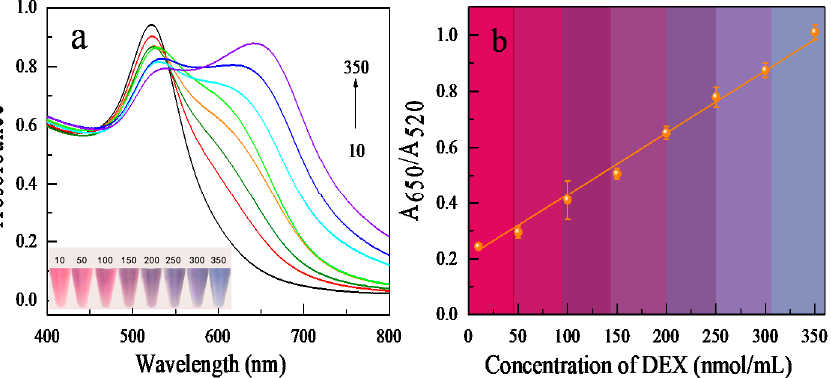
Figure 4. The aptamer-based DEX detection assay’s sensitivity. ( a ) Color and UV absorption spectra of sensing systems treated with 10, 50, 100, 150, 200, 250, 300, and 350 nmol/mL DEX. ( b ) A plot depicting the linear response at different concentrations.